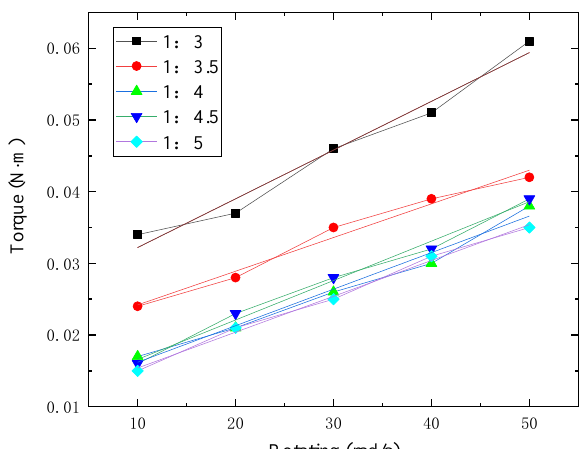
Figure 13. Relation between rotating speed and torque at different ratios of cement to fly ash in the slurry.